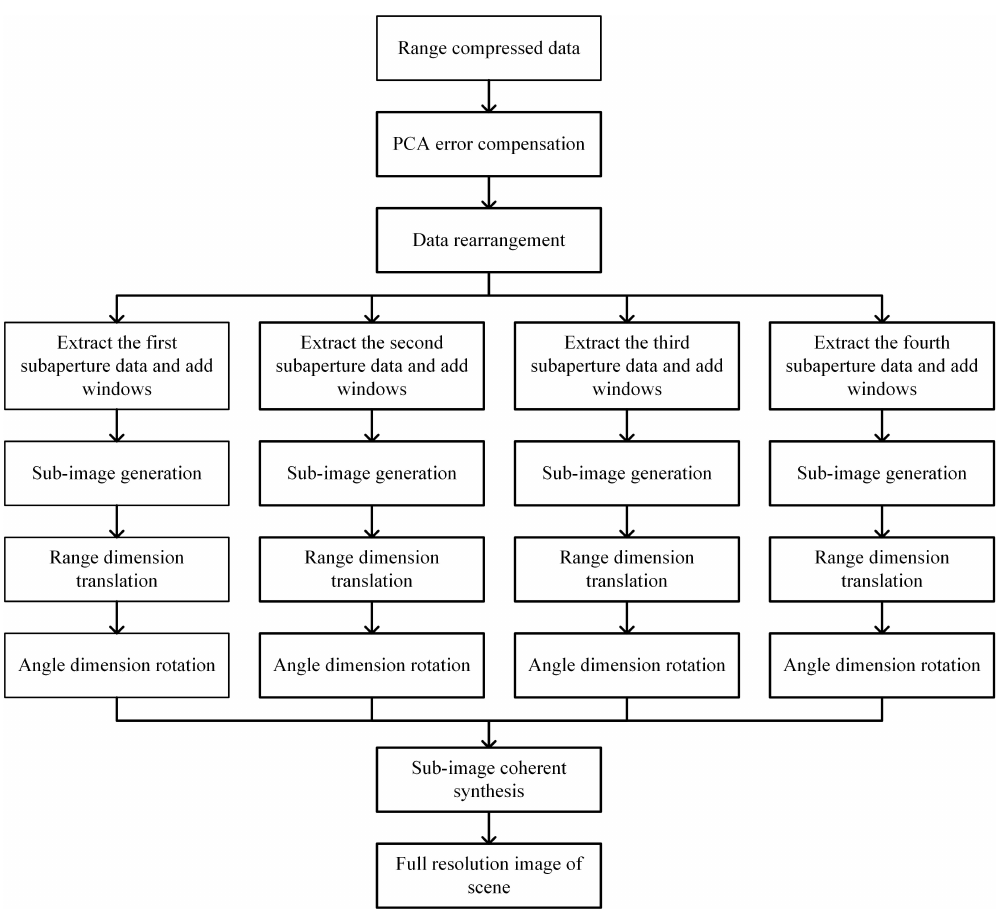
Figure 13. The processing flow